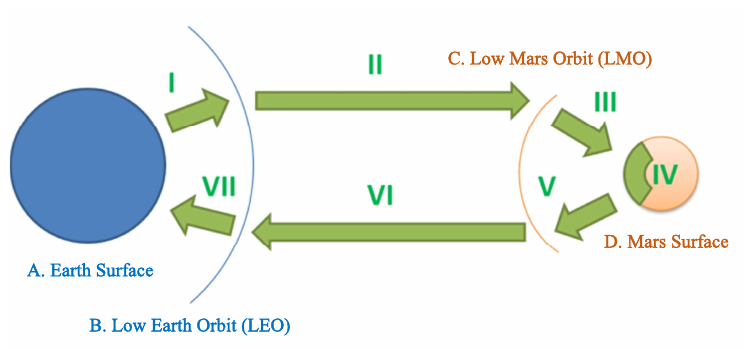
Figure 9. Four mission nodes and seven mission phases in manned Mars mission.